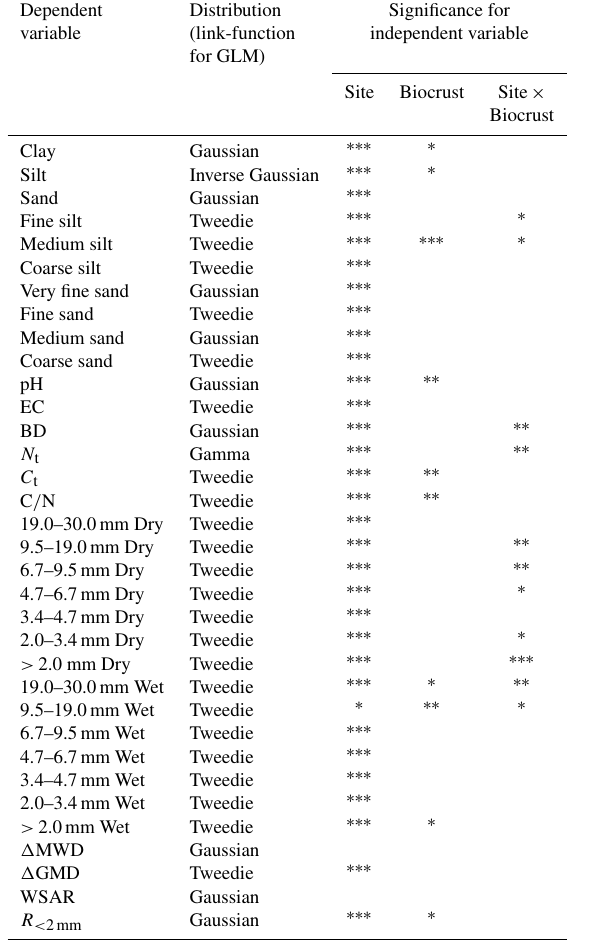
Table A1. Significant factors for response variables based on generalized linear models. Models with significant interaction also include the predictors as simple parameters based